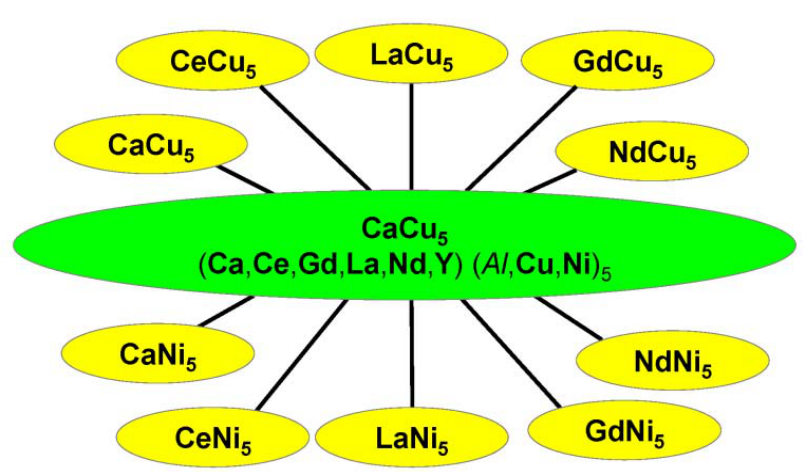
Figure 10. Sketch of the unified model of the multicomponent phase CaCu connection to all stable binary phases.